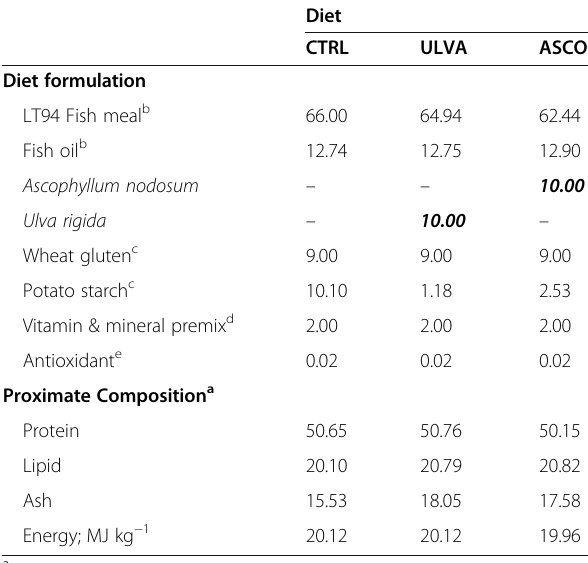
Table 2 The experimental diet formulations and their proximate composition (%, dry